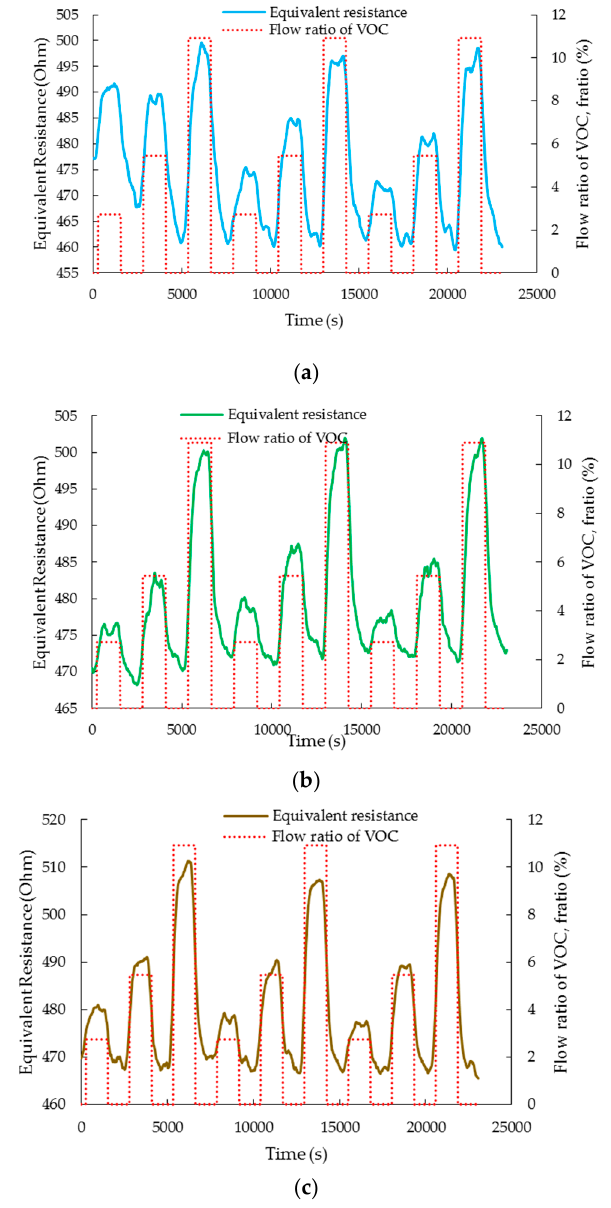
Figure 5. The dynamic response of the sensor’s equivalent resistance ( a )–( c ) towards flow ratios of 2.73%, 5.45%, and 10.91% of ethanol, acetic acid, and ethyl acetate VOC molecules, respectively. The flow ratio variation of the VOC is shown in the secondary vertical axis. A value of V ratio = 0 indicates the absence of VOC molecules in the flow.